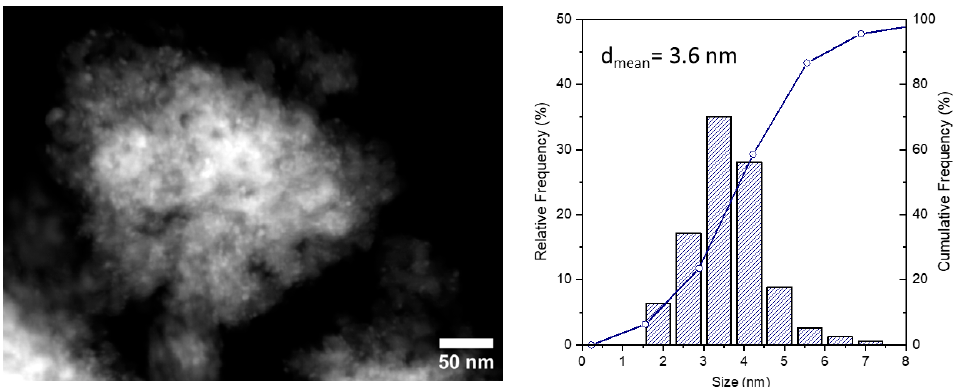
Figure 7. Representative STEM micrographs of CuO@SiO 2 -MN after 43 h of catalysis under flow and related particle size distribution.